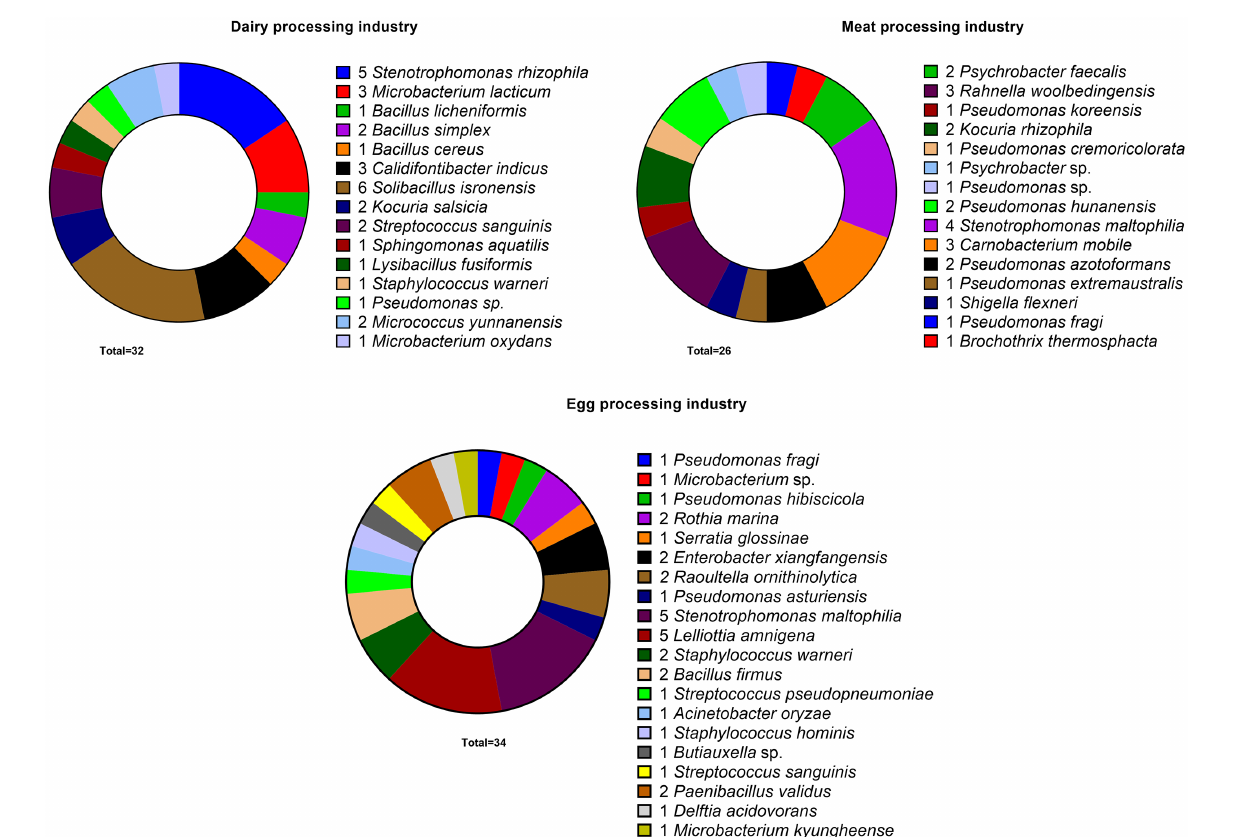
FIGURE 1 Details concerning number, identification and origin of 92 bacterial strains that were studied for their biofilm forming ability and synergistic interactions in multispecies biofilms. The strains were originated from three food processing industries: dairy, meat, and egg processing industries after routine cleaning and disinfection